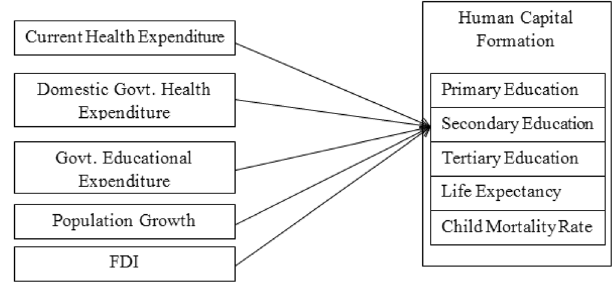
Fig. 2 Conceptual framework. Factors affecting human capital